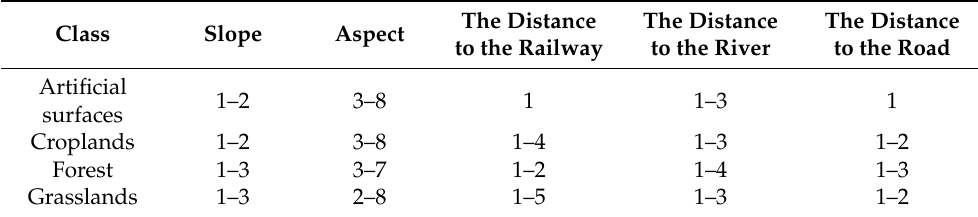
Table 4. Suitability constraints for changes in construction land, cultivated land, forest land and